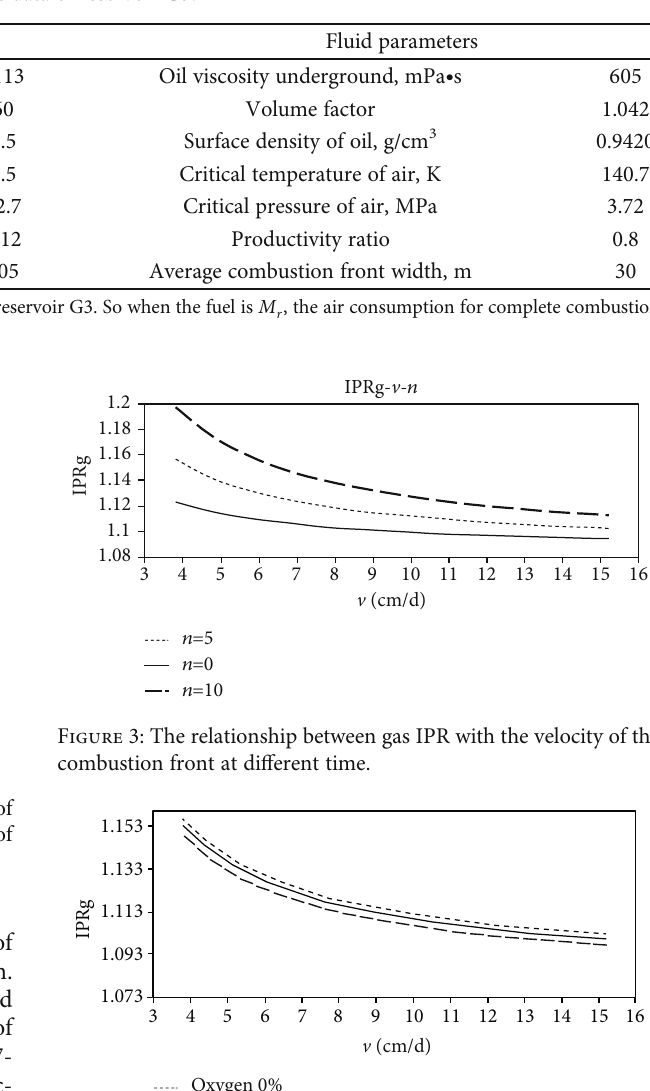
Table 1: Basic data of reservoir G3.